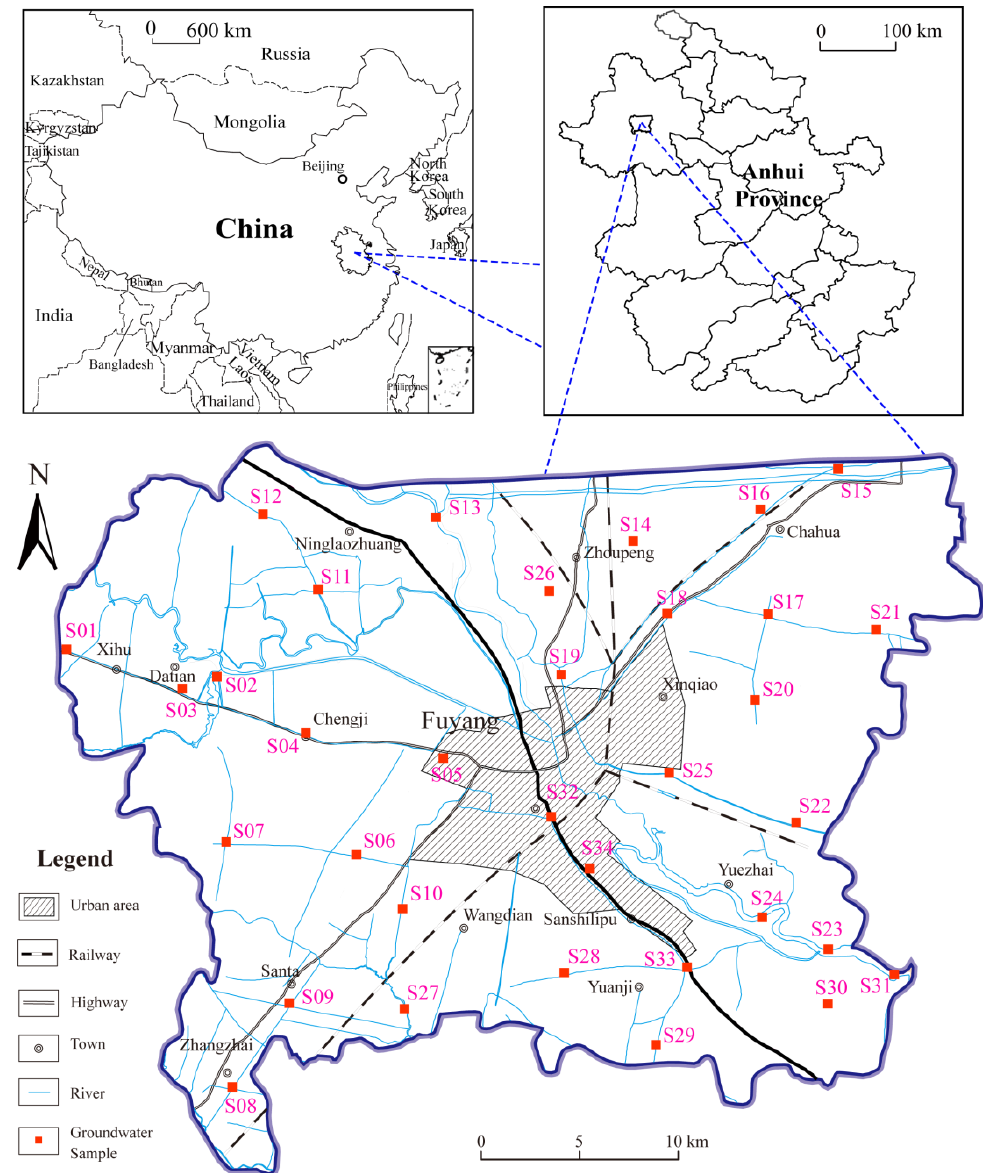
Figure 1. Map of the study area and location of shallow groundwater sampling sites.